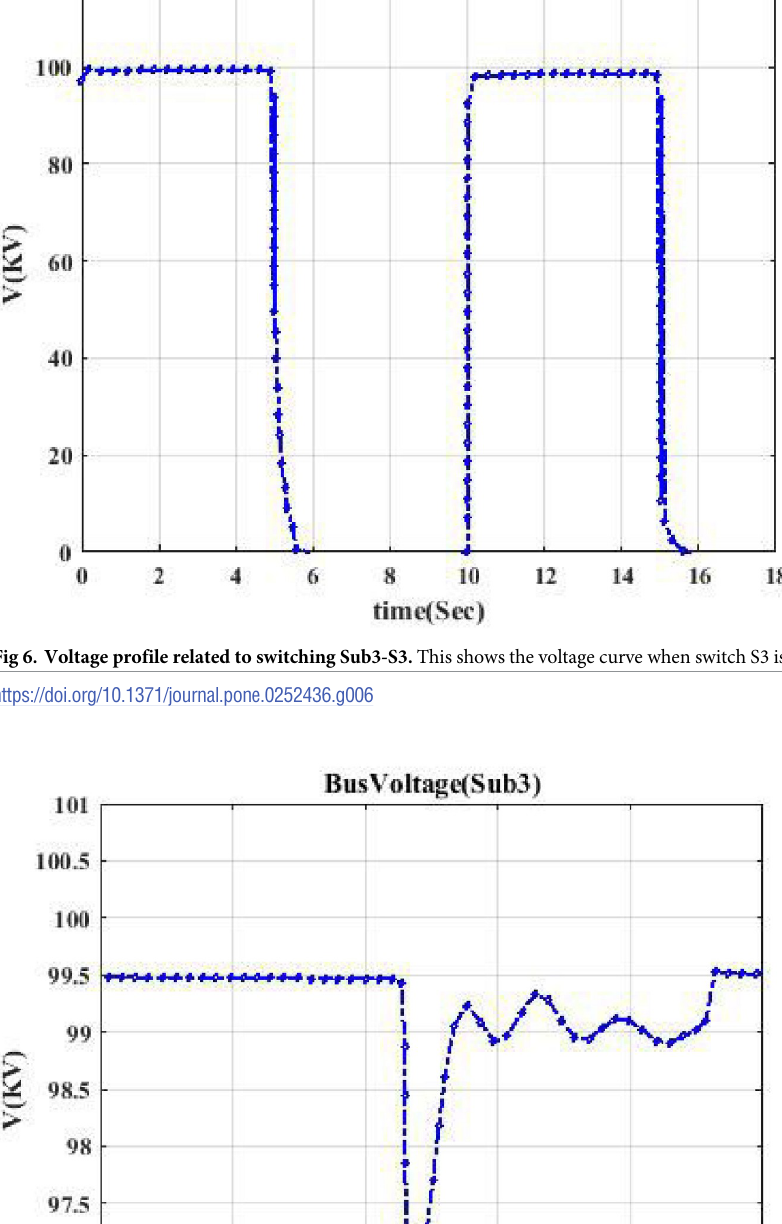
PLOS ONE | https://doi.org/10.1371/journal.pone.0252436 June 1,